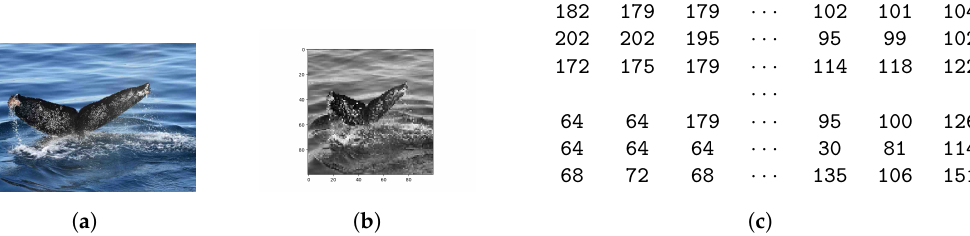
Figure 7. Scale image process. From an HD image to a resized and gray image represented as a matrix (such representation is needed to train the model). ( a ) HD image. ( b ) Gray and scaled image. ( c ) Matrix